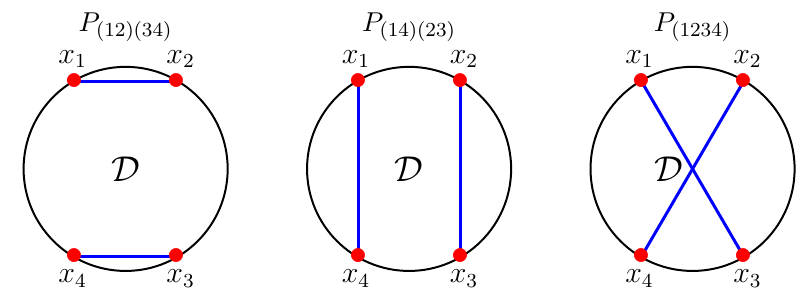
Figure 1 . Four points x 1 ; x 2 ; x 3 and x 4 are marked on the boundary of a simply connected domain embedded into a regular two-dimensional lattice. The function P is the probability that x 1 (12)(34) D and x 2 are connected into one FK cluster while x 3 and x 4 are connected into a di(cid:11)erent FK cluster. Analogously P is the probability that x 1 and x 4 are connected into one FK cluster while x 2 (14)(23) and x 3 are connected into a di(cid:11)erent FK cluster. Finally P is the probability that all the points (1234) belong to the same FK cluster. The non-normalized probability measure of any con(cid:12)gurations (i.e. of any random graphs ) is given in eq. G